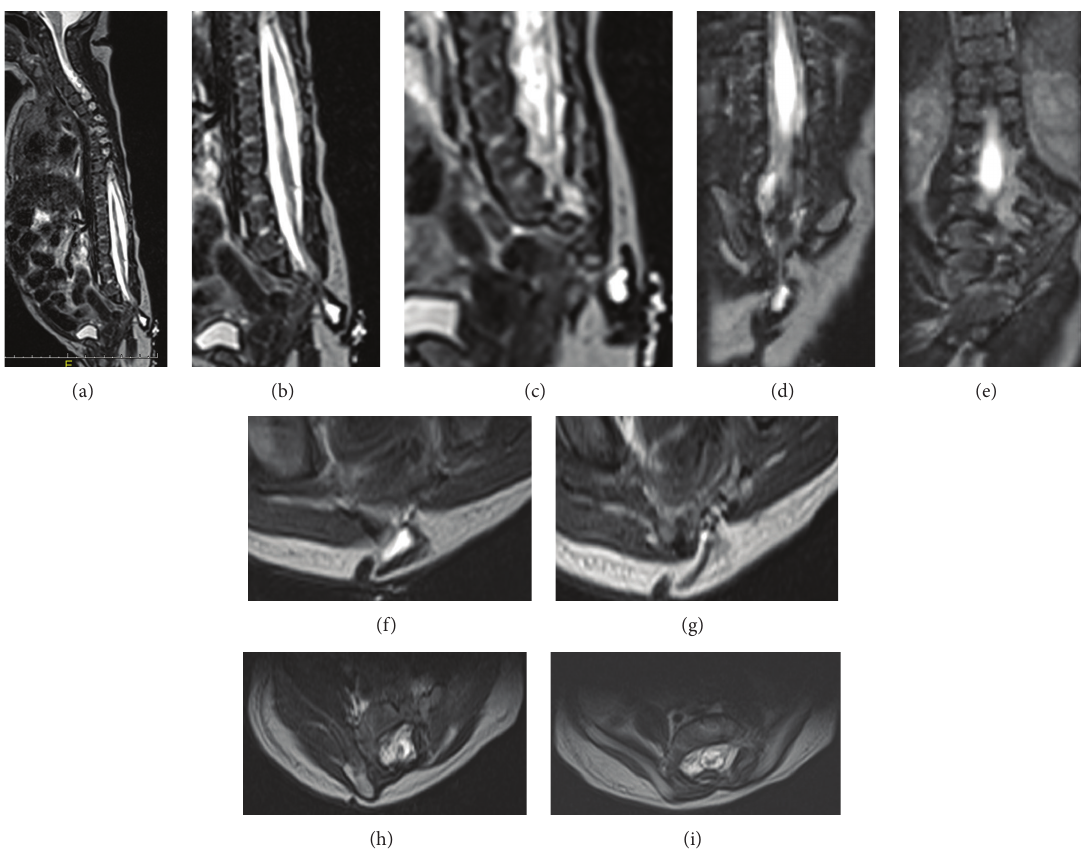
Figure 2: MRI T2 sagittal (a, b, c), axial (f, g, h, i), and coronal (d and e), for the spine demonstrating widening of bony spinal canal and 2ry dural ectasia (short arrows), abnormal sacral segmentation (bold arrows) and partial sacral agenesis and hypoplasia (long arrows), deformity of the iliac bone (circle), the meningocele (arrow head), and the fibrous band (curved arrow) related to